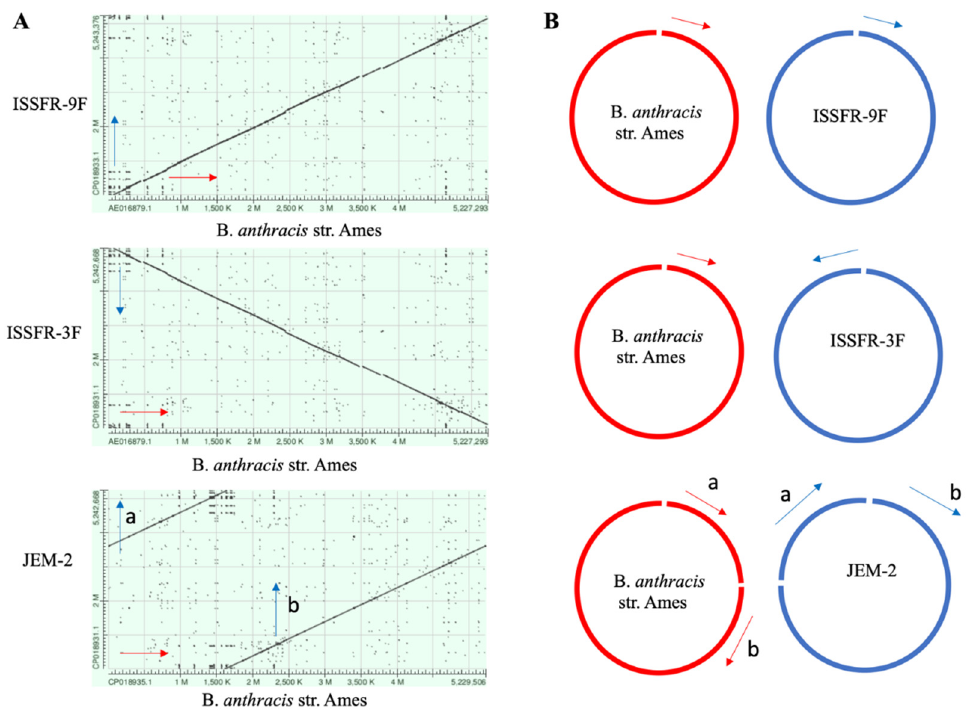
Figure 6. Synteny matrix (dot-plot) analyses of the Bacillus ISS strains with B. anthracis str. Ames. ( A ) Dot Plot representations (BLAST score ratio-based synteny plots) of alignments between B. anthracis str. Ames chromosome (X-axis) and the ISS Bacillus strains (Y-axis). Each point on the figure represents an individual peptide in B. anthracis str. Ames genome compared to the proteome of the ISS strains. (B) Graphic representation of the plots showed in (A). The ISSFR-3F strain showed the same orientation of the B. anthracis str. Ames. The ISSFR-3F chromosome show a reverse relative orientation compared with the B. anthracis str. Ames chromosome. The JEM-2 chromosome shows a translocation: the chromosome segment indicated with (a) in B. anthracis str. Ames corresponding to the first part of the chromosome, is found in the last part in JEM-2. GeneBank accession numbers: